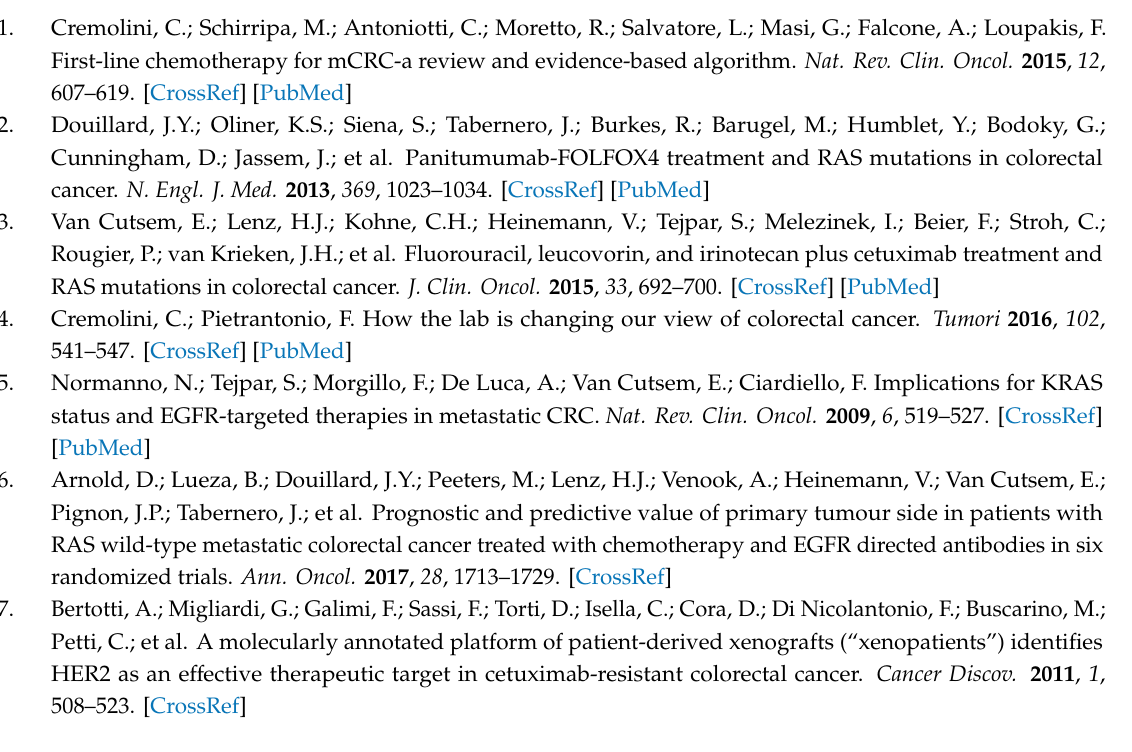
Table S1: Clinical data, histopathological characteristics and variants identified in the cohort of 21 quadruple-wt mCRC